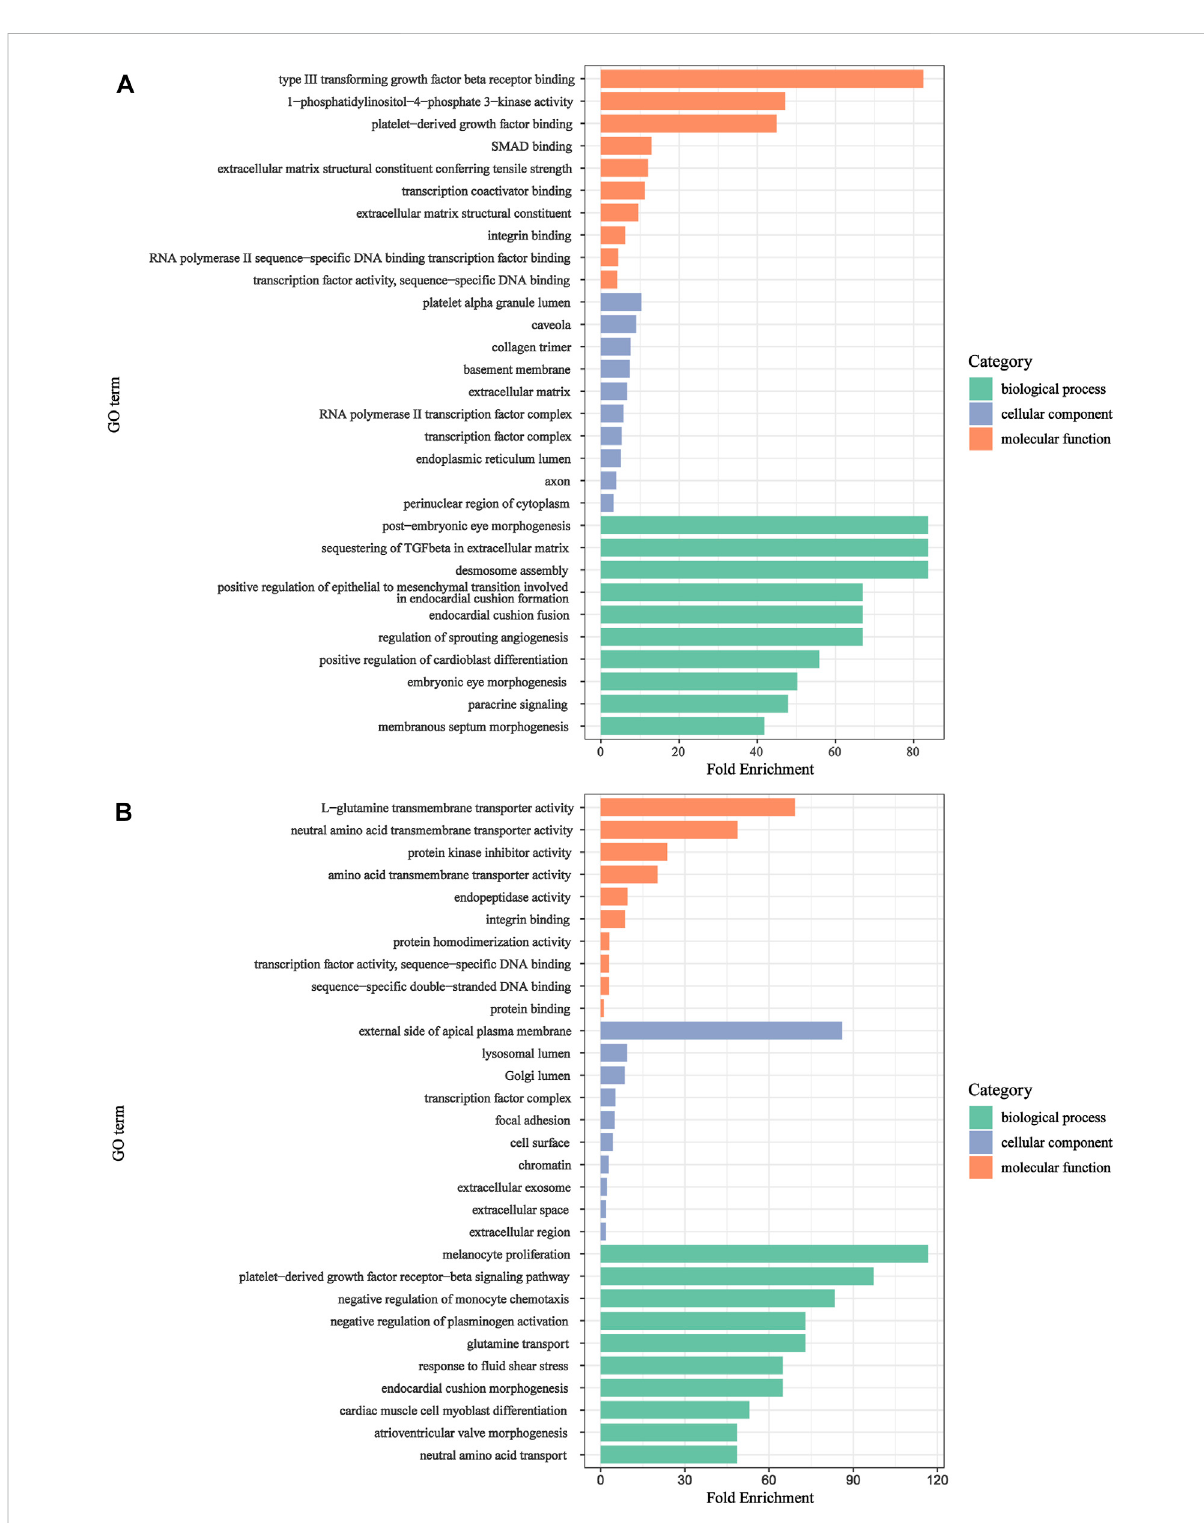
FIGURE 5 GO annotation analysis for candidate genes in the biological process, cellular component, and molecular function. (A) : upregulated genes. (B) : downregulated